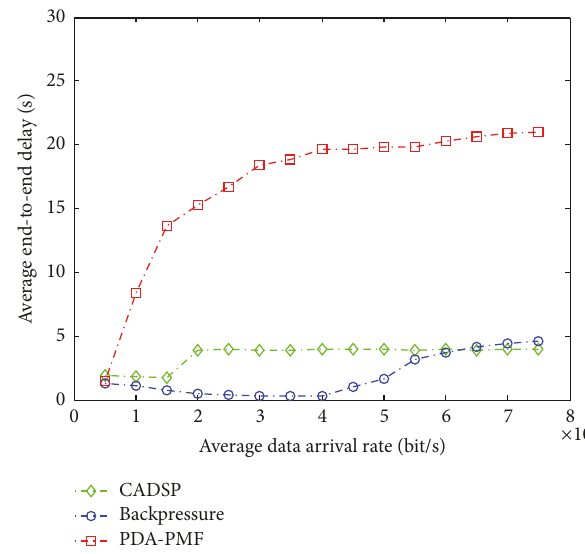
Figure 7: Comparison of average end-to-end delay of service 3 in multihop network.